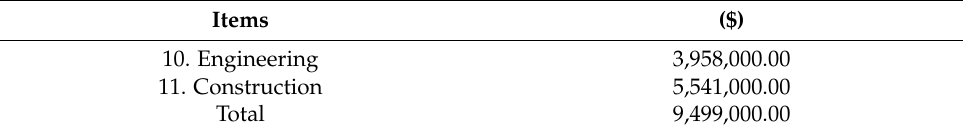
Table 2. Total Plant Indirect Cost